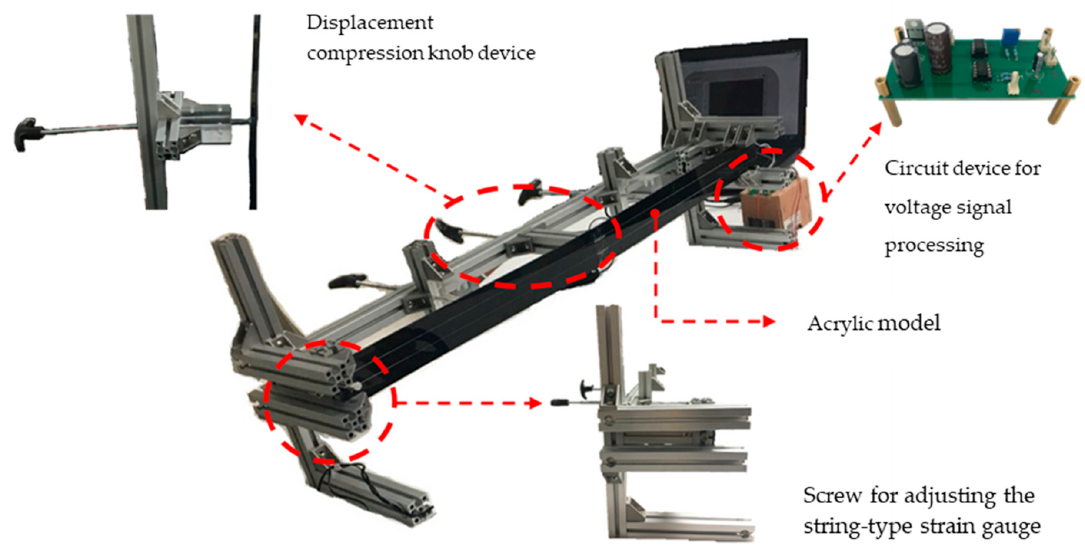
Figure 6. Aluminum frame for the acrylic model experiment.